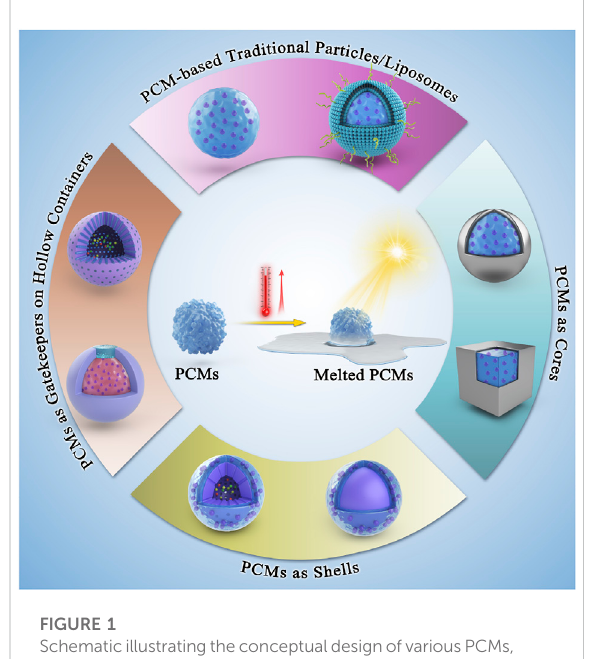
FIGURE 1 SchematicillustratingtheconceptualdesignofvariousPCMs, in terms of positioning the PCMs and their successive nanoconjugates for